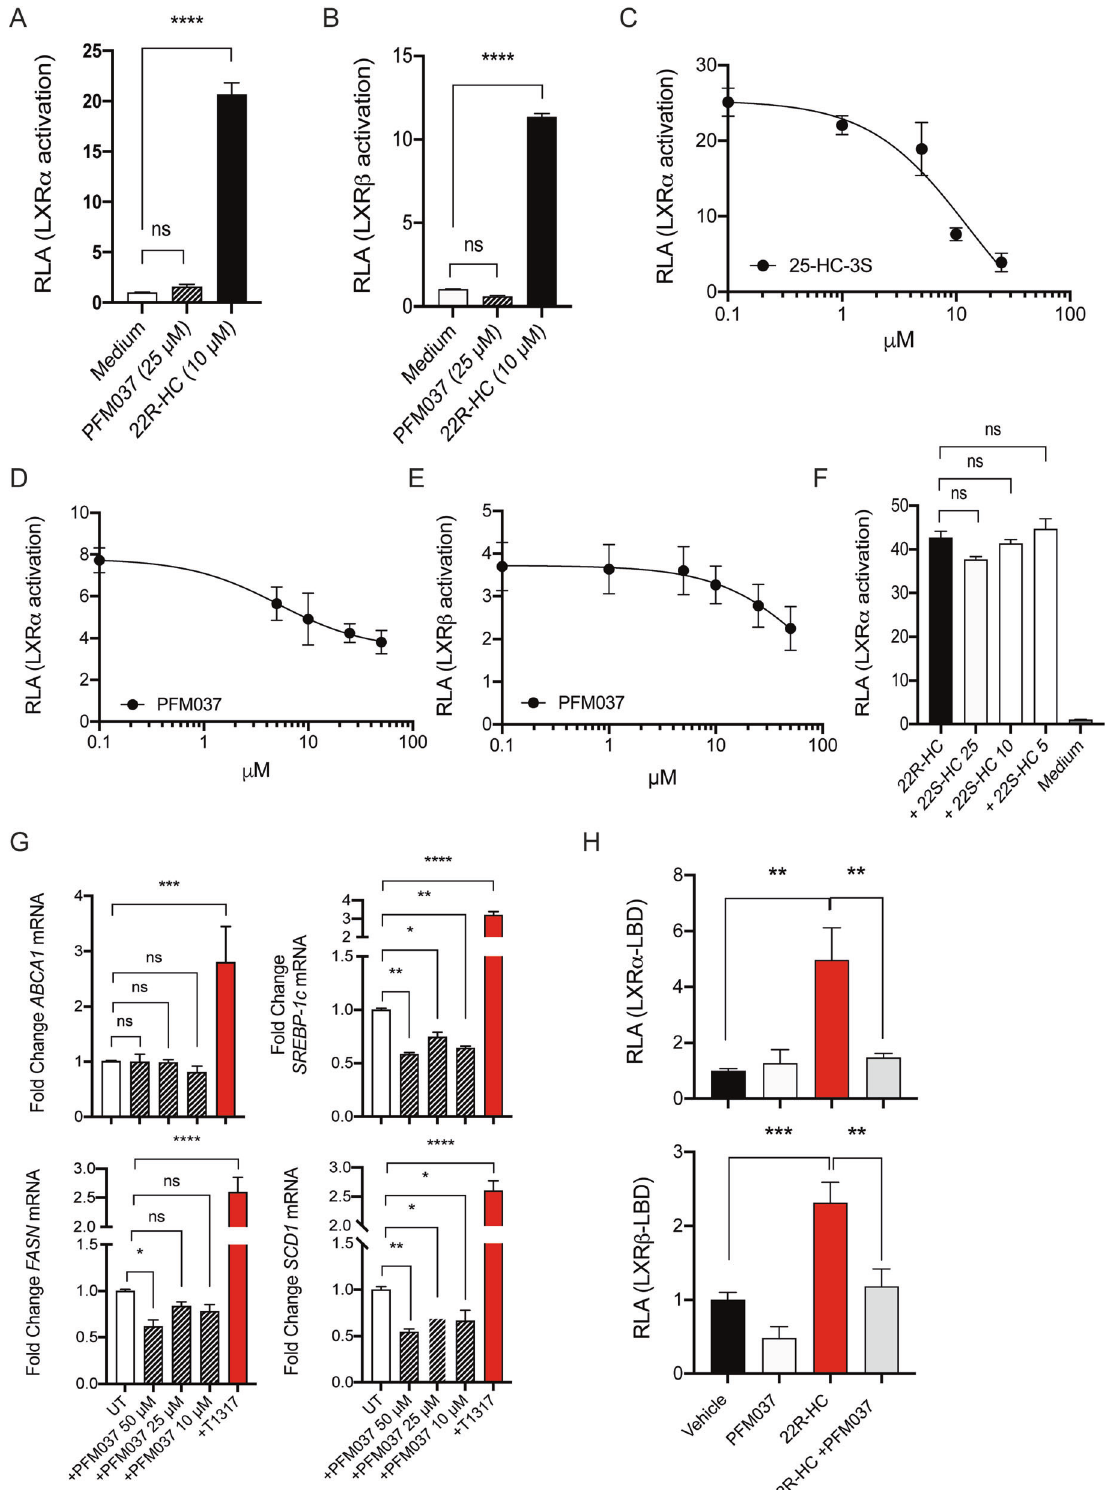
(Fig. 9E) in immunocompetent mice bearing the melanoma B16F1-OVA and treated with the combination of PFM037 and in vitro activated OT-I T cells. Thus, indicating that SULT2B1b/ PFM037 treatments reprogram the hostile tumor microenvir- onment into an immune-sensitive